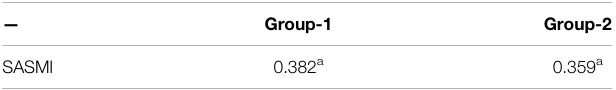
TABLE 7 | Correlation between summer precipitation and SASMI in different precipitation regions.